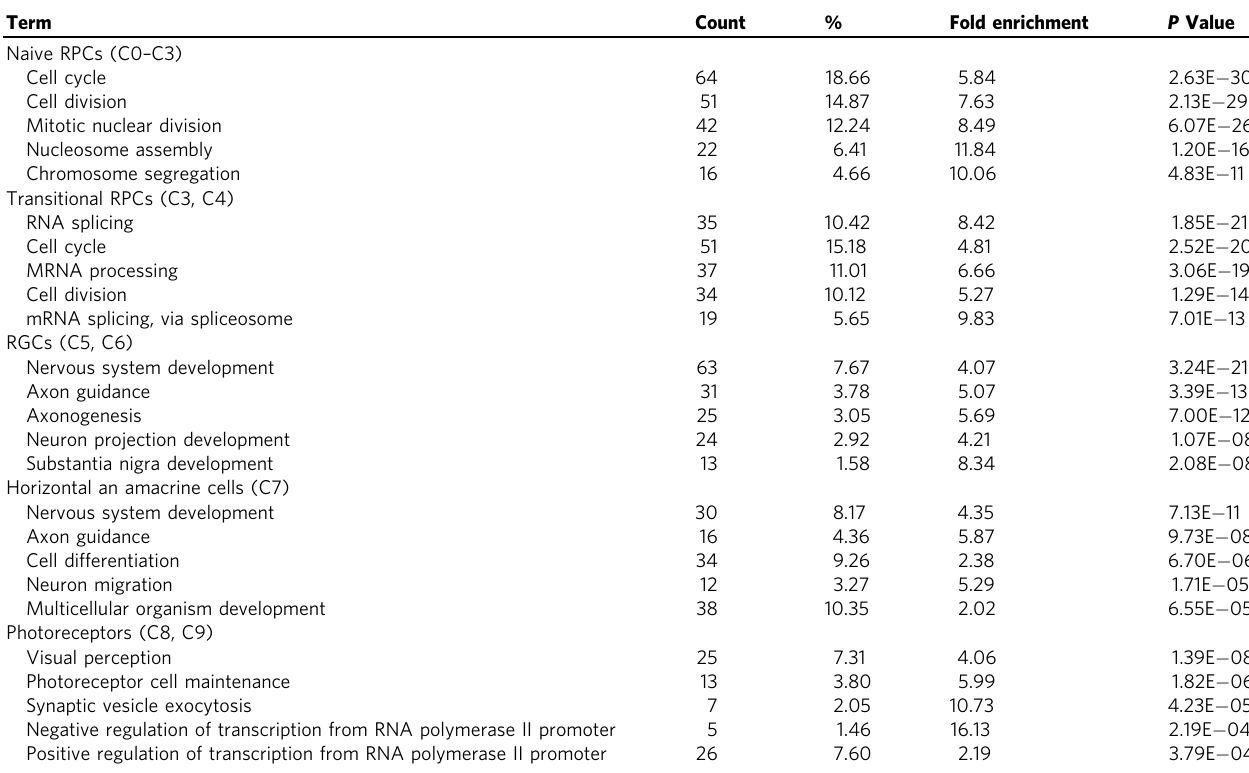
Table 1 Enriched GO terms for individual cell states/types. Term